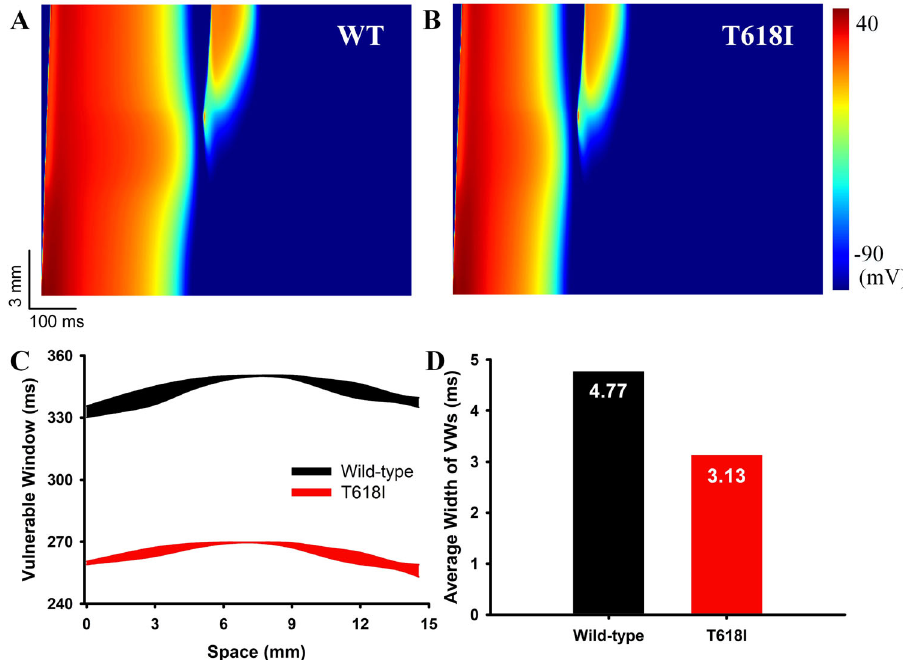
Fig. 3 Simulation results of the unidirectional conduction block using the transmural 1D strand. A The evoked unidirectional conduction block in the wild-type condition. B The unidirectional conduction block in the T618I mutation condition. C Distributions of VWs in the two conditions. D The comparison of the average VW width in the two